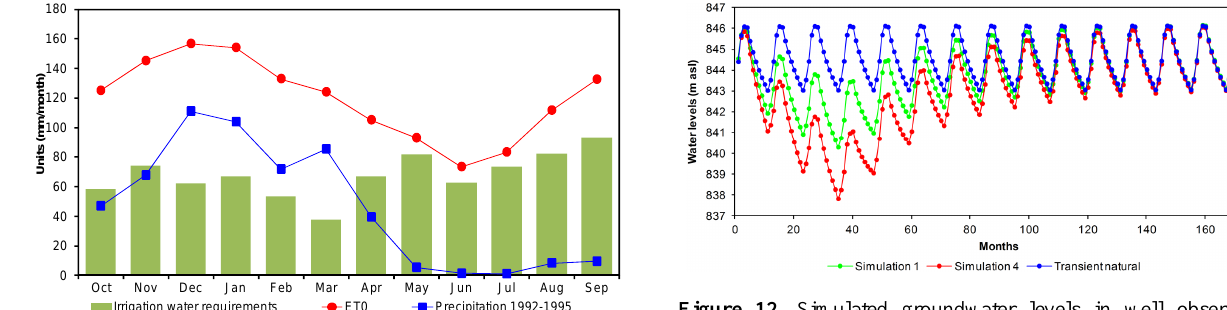
Figure 12. Simulated groundwater levels in well observation AC00232 at White River